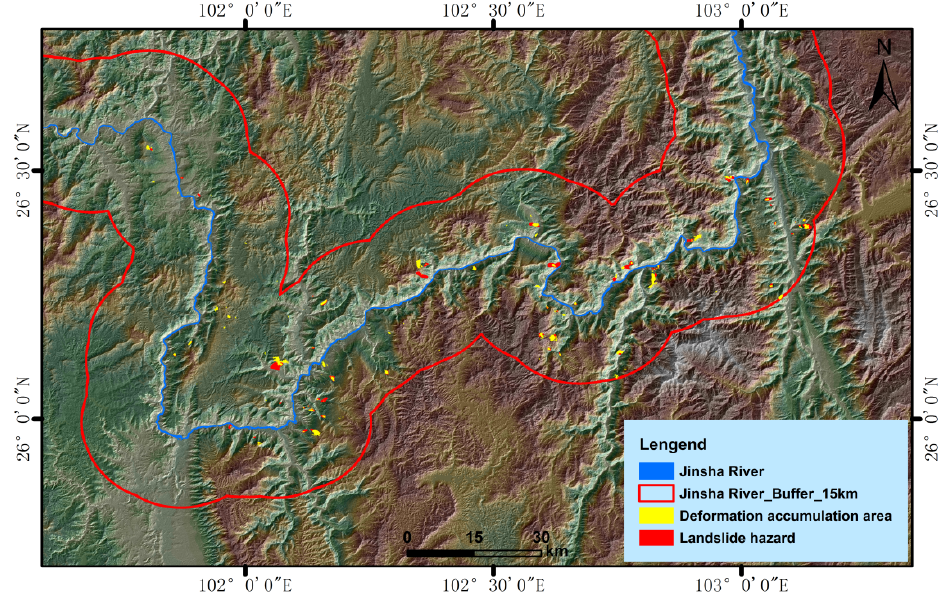
Figure 6. Spatial distribution of the deformation accumulation area and potential landslide hazards.